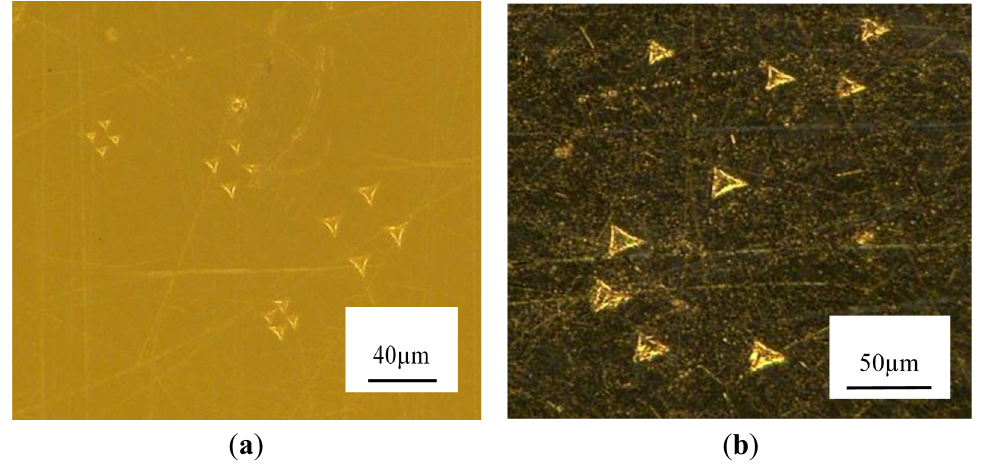
Figure 2. Indentation points ( a ) Polyetheretherketone (PEEK); ( b ) 30 wt% carbon-fibers reinforced Polyetheretherketone (PEEK CF 30).